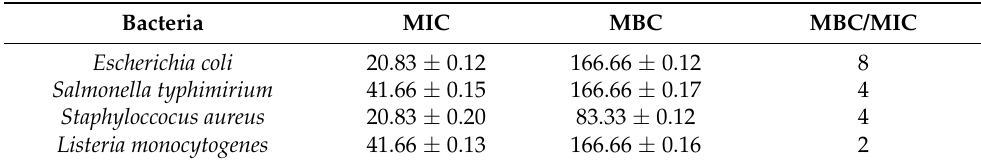
Table 3. MIC (minimum inhibitory concentration) and MBC (minimum bactericidal concentration) values displayed by Anacyclus clavatus flower extract against bacterial strains (mg/mL). Values are expressed as means ±